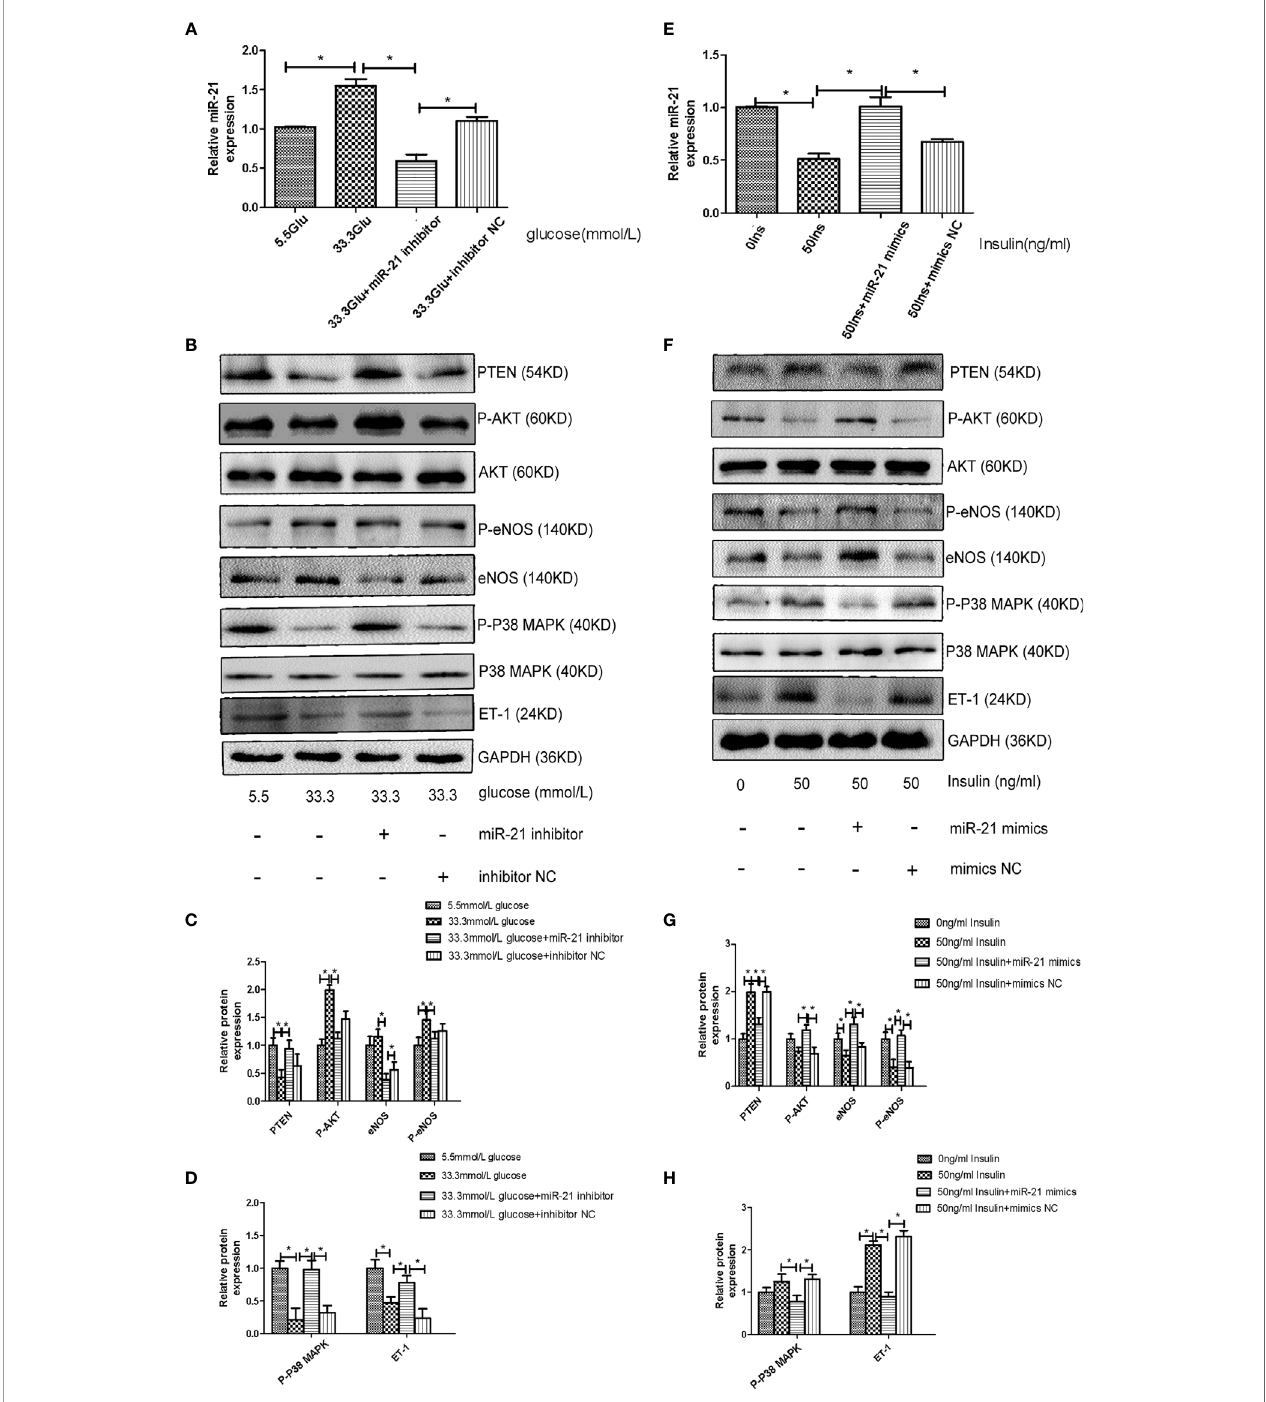
FIGURE 4 | MiR-21 inhibitor/mimics blocked the impact that high concentration glucose/insulin had on downstream pathways. (A) : qRT-PCR analysis of miR-21 in HGECs transfected with miR-21 inhibitor or inhibitor NC and treated with different concentrations of glucose. (B) : Westernblot analysis of PTEN/AKT/eNOS and MAPK/ET-1 pathways in groups in (A). (C, D) : Quanti fi cation of result in (B) . (E) : MiR-21 levels in HGECs transfected with miR-21 mimics or mimics NC and treated with different concentrations of insulin. (F) : Westernblot analysis of PTEN/AKT/eNOS and MAPK/ET-1 pathways in groups in (E) . (G, H) : Quanti fi cation of result in (F) Data are reported as mean ± SD, *P < 0.05. All data are representative of three independent experiments. Glu, glucose; Ins, insulin; NC, normal